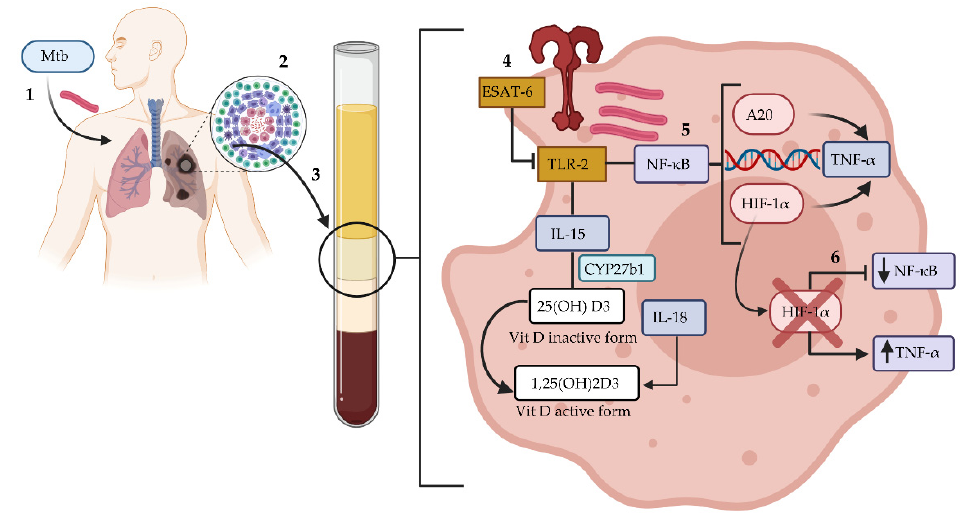
Figure 6. Possible mechanisms activated in PBMCs isolated from individuals with LTBI. (1) After the initial infection, the bacilli reach the lungs and are recognized by alveolar macrophages. (2) In most infected individuals, the bacilli are contained in structures called granulomas. (3) PBMCs are recruited to the site of infection. (4) Mycobacterium tuberculosis produces several virulence factors for cell survival, including ESAT-6, which interacts with toll-like receptor 2, activates proinflammatory cytokines, and modulates IL-15-mediated activation of vitamin-D-dependent antimicrobial pathways. (5) The NF- κ B pathway activates transcription factors, such as A20, which is involved in negative feedback inhibition of NF- κ B, and HIF-1 α , the central regulator of the hypoxic response. (6) Inhibition of HIF-1 α results in decreased phosphorylation of NF- κ B but increased production of TNF- α , bypassing NF- κ B and HIF-1 α pathways. The figure was created using Biorender.com. Abbreviations: ESAT-6, early secretory antigen target; HIF-1 α , hypoxia-inducible factor 1 alpha; IL, interleukin; Mtb, Mycobacterium tuberculosis; NF- κ B, nuclear factor kappa B; TLR-2, toll-like receptor 2; TNF- α , tumor necrosis factor-alpha; Vit, vitamin.